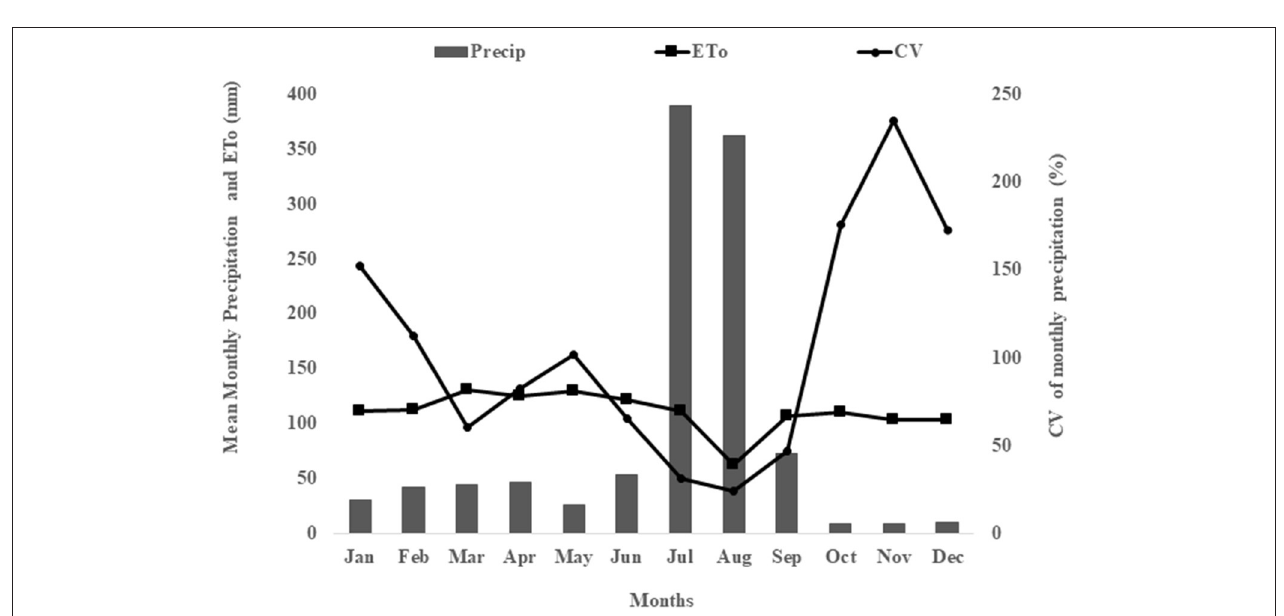
FIGURE 2 | Mean monthly precipitation, reference evapotranspiration, and Coefficient of Variability computed from long-term daily meteorological data during 2001–2020 for Barneb 2 small-scale irrigation scheme in Northeastern Ethiopia .